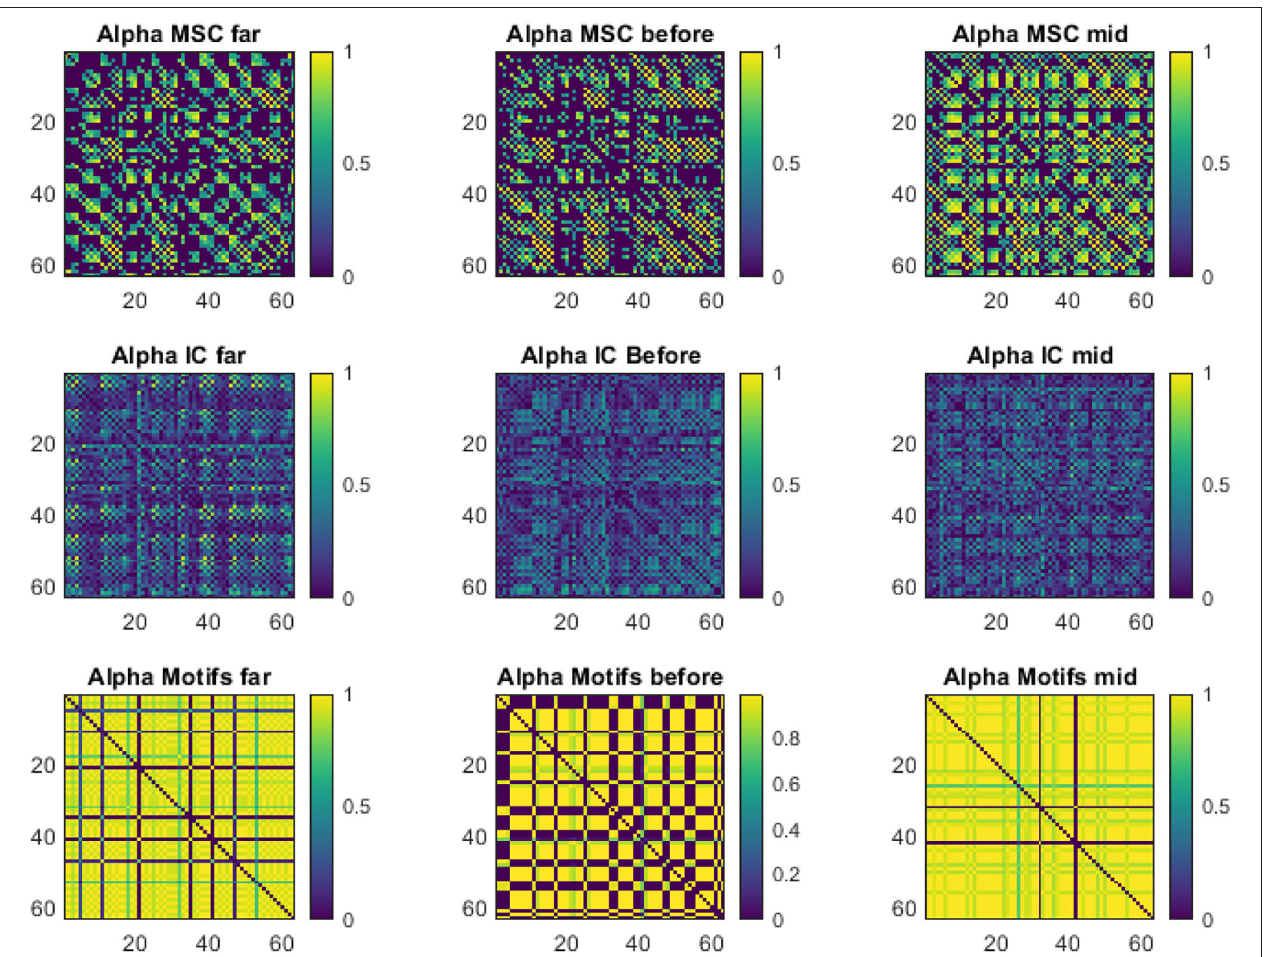
FIGURE 4 | Alpha band FC matrices of a patient for three representative epochs of EEG segment types far, before, and mid (columns). Each epoch is represented by three matrices, one for each FC technique. Top row: MSC, middle row: IC, bottom row: motifs.